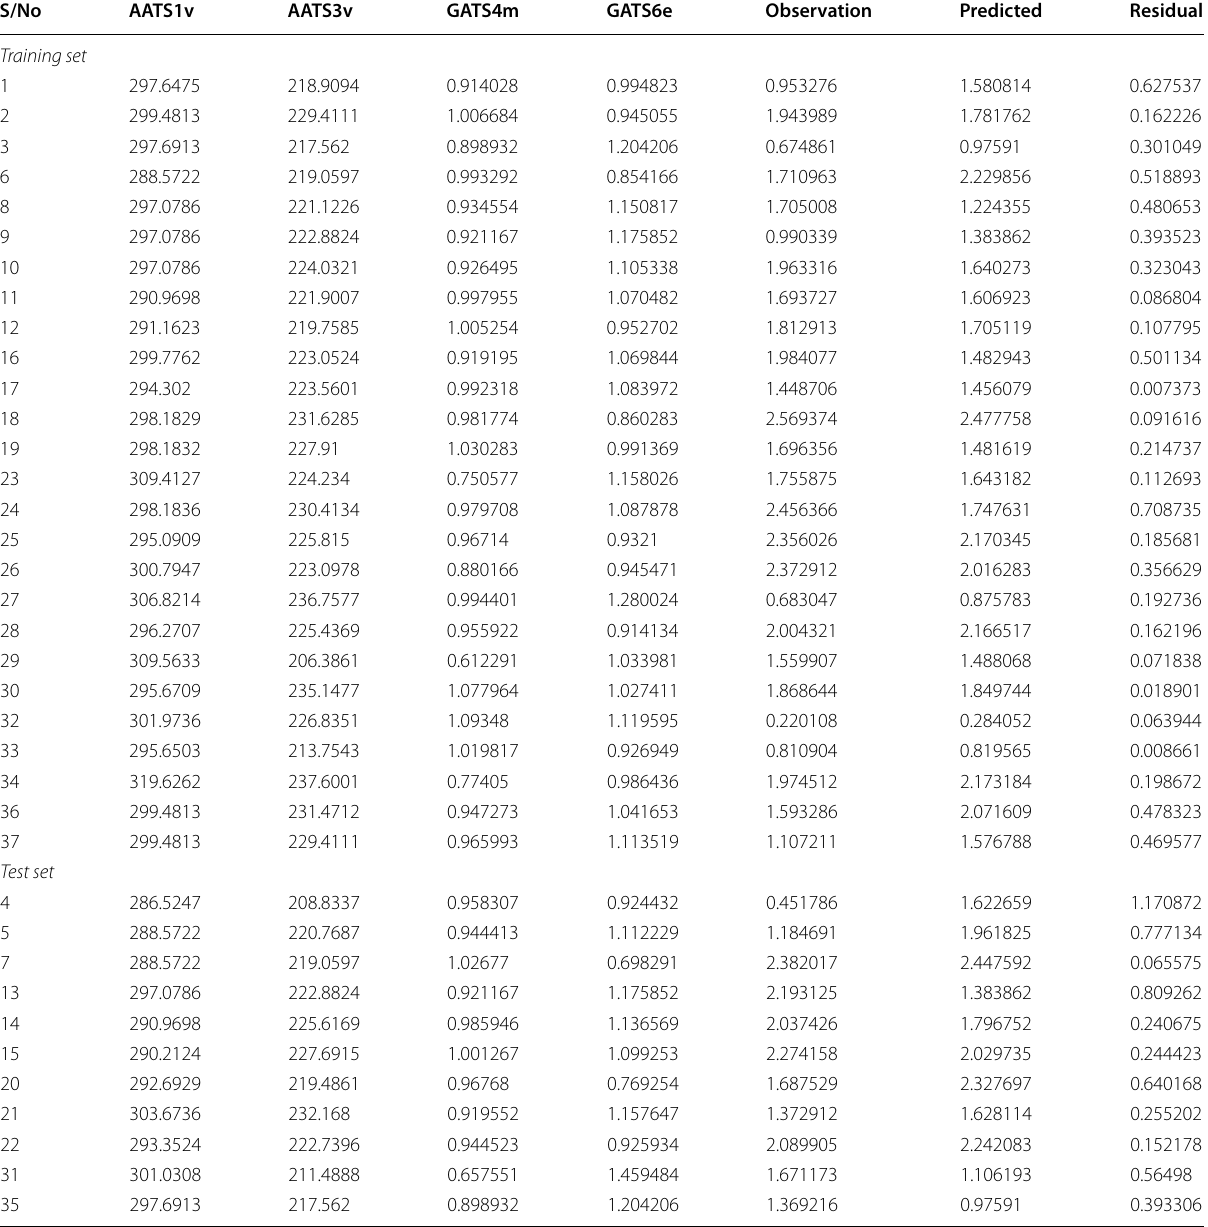
Table 2 Descriptor calculation for